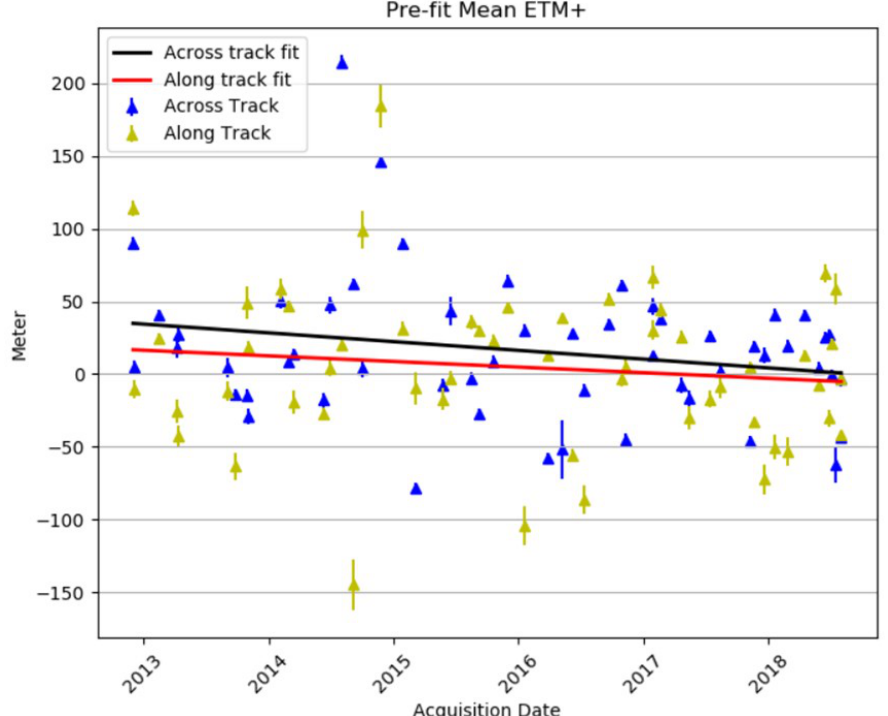
Figure 16. Geodetic accuracy pre-fit mean results for the verification scenes after calibration. The trend associated with the across track means is shown as a black line. The upward trend for the across track direction that was present in Figure 15 is no longer present.